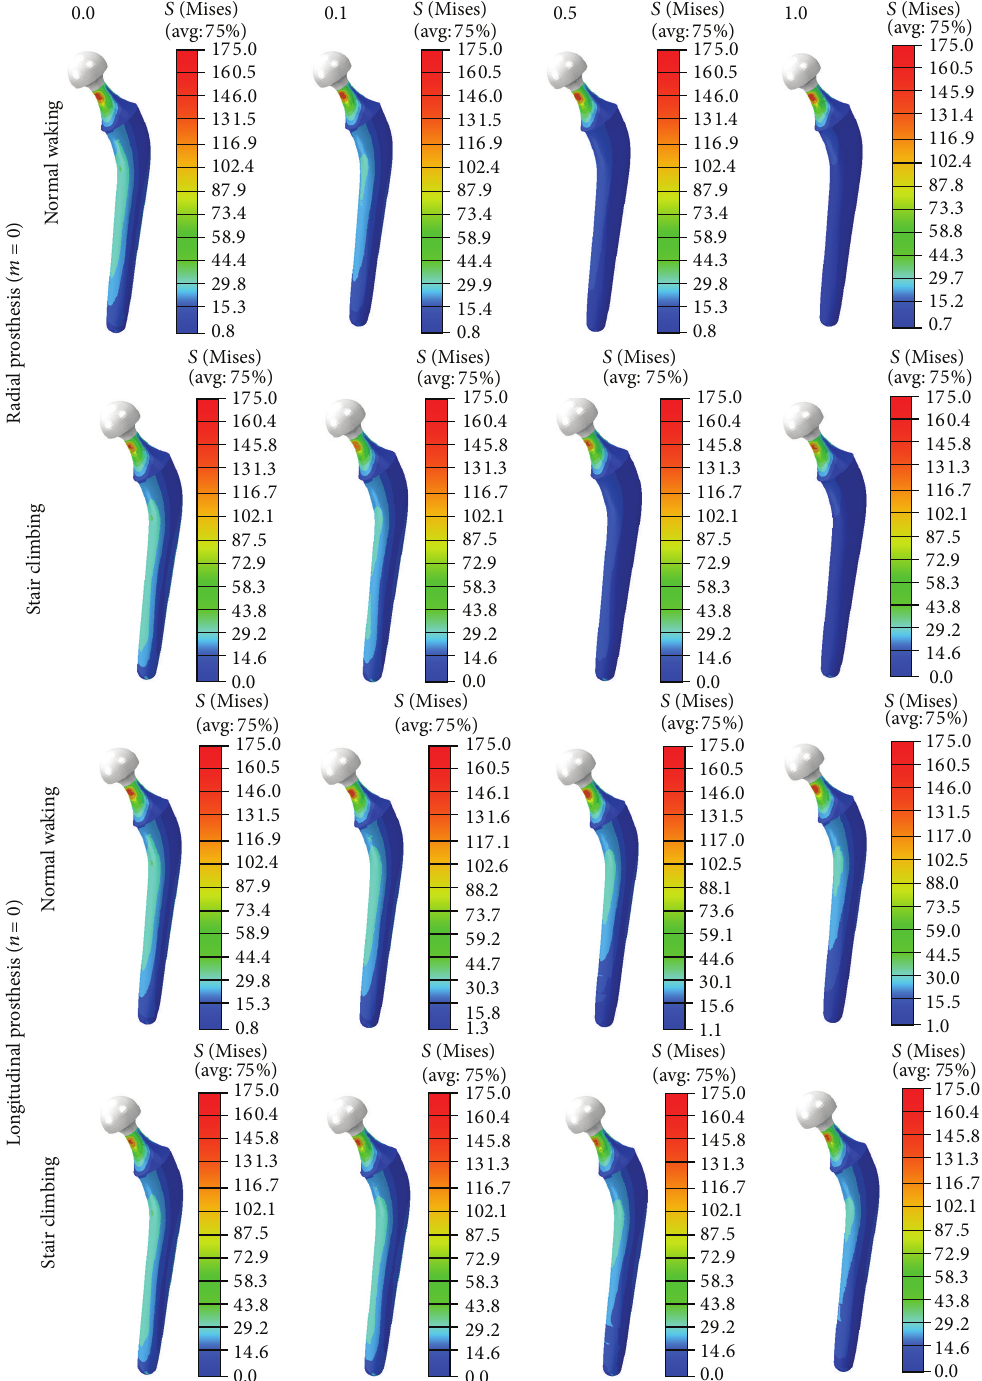
Figure 5: The von Mises stress distribution in the radial and longitudinal directions of the noncemented prostheses, under normal walking and stair climbing